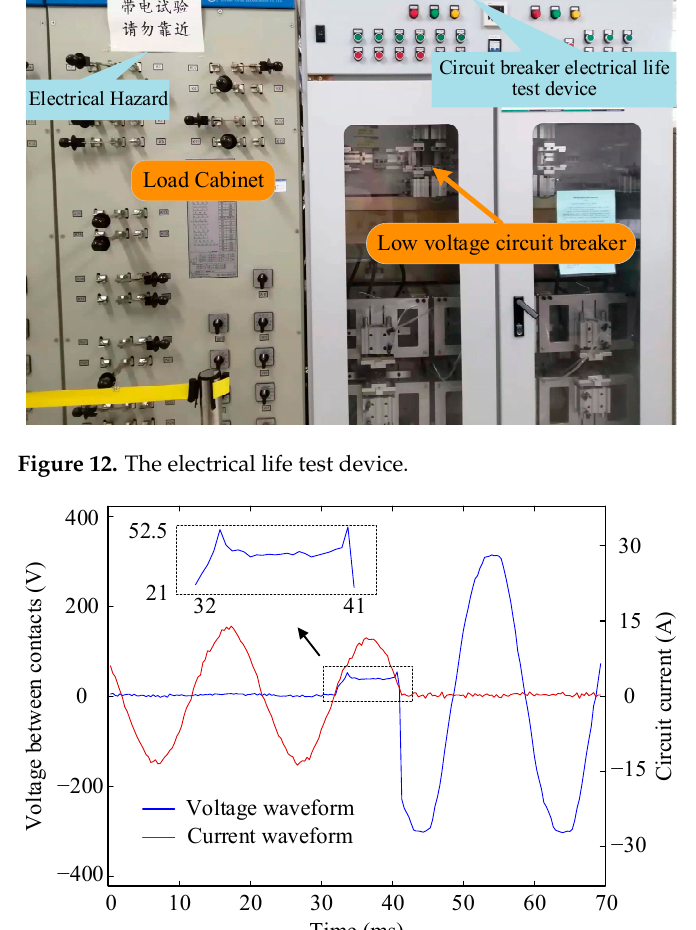
Figure 13. Voltage and current waveforms.